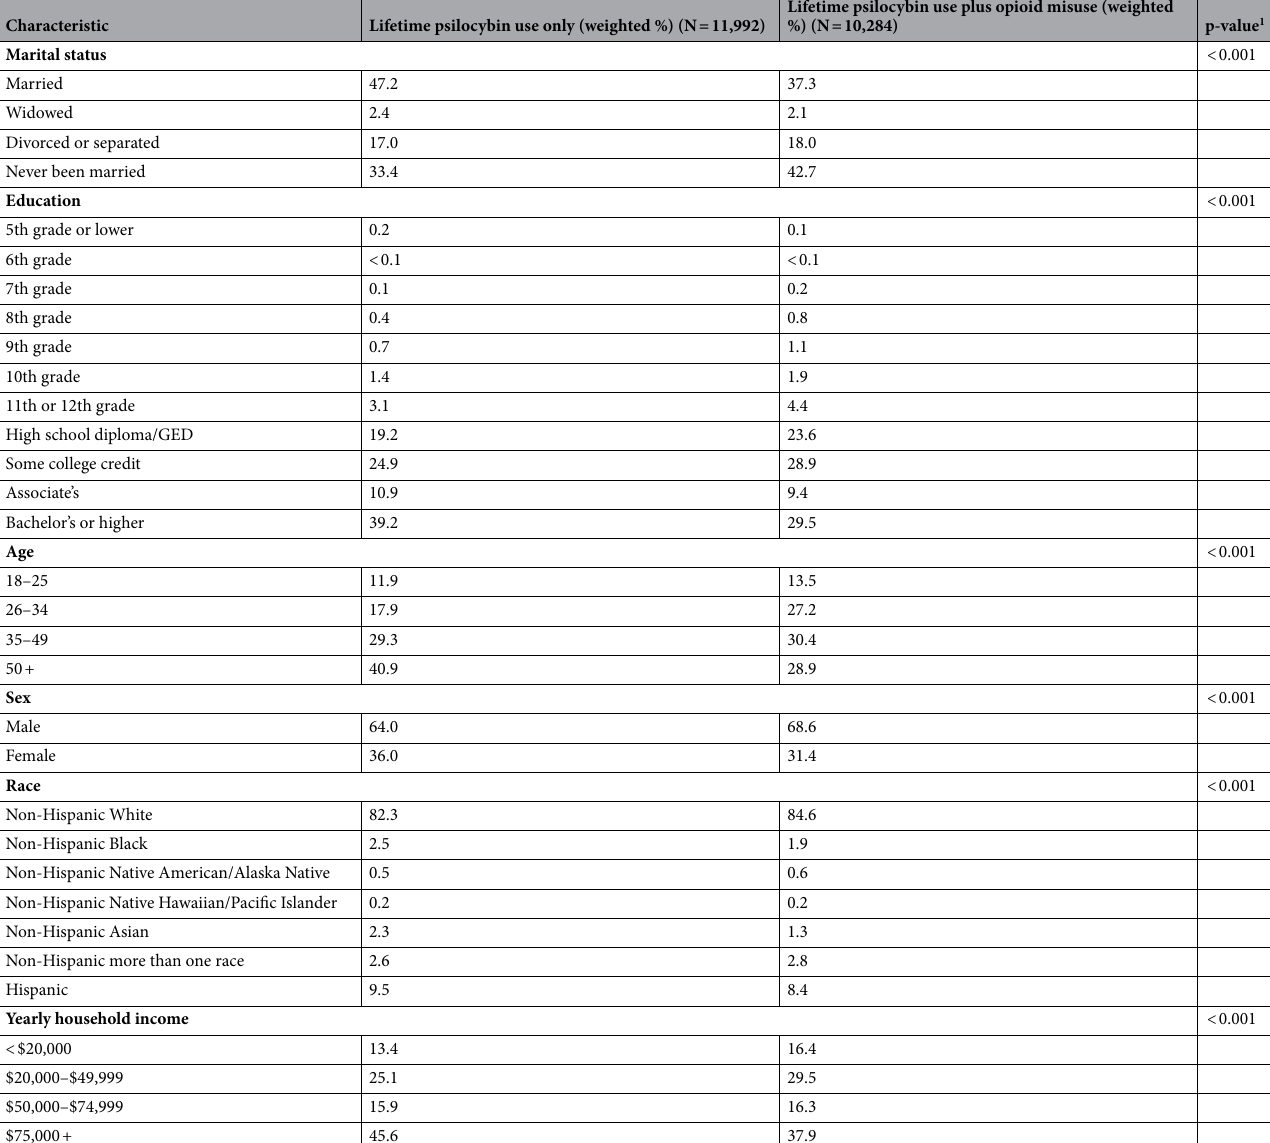
Table 4. Demographic differences for psilocybin users who have versus have not misused opioids. 1 Chi- squared test with Rao and Scott’s second-order